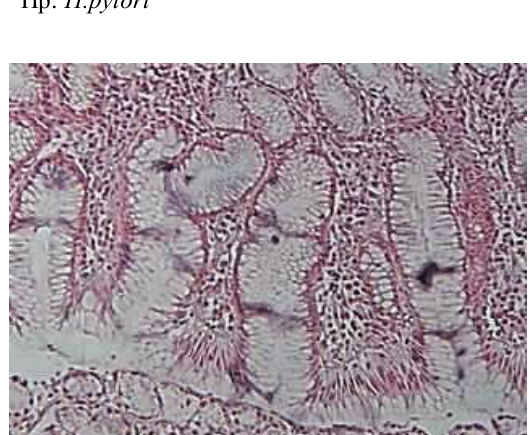
Table (1): Expression of CagA mRNA in H.pylori – positive patients with chronic gastritis by (ISH).